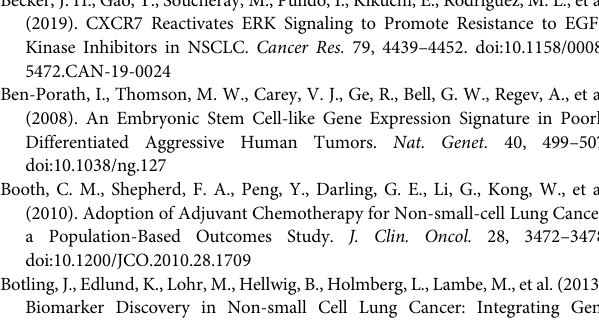
Supplementary Figure S1 | The work fl ow diagram. Regulons which were pre- computed from 7 LUAD gene expression datasets are ready to use. For a given prognostic signature, master regulators were identi fi ed with two analytical steps. Tools and methods used in this work fl ow were highlighted in